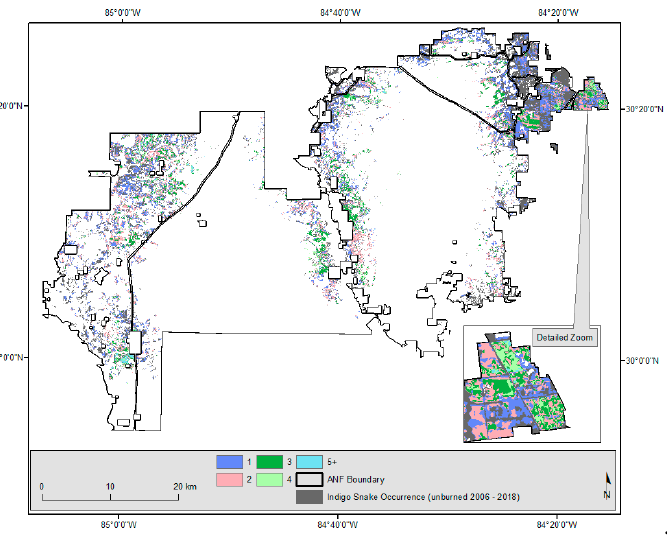
Figure 5. Fire frequency (2006–2018) restricted to Indigo snake occurrence locations is shown across the Apalachicola National Forest (ANF) at 30 m resolution. This example application demonstrates how the FRQ fire metrics can be potentially used to guide species-level habitat management activities. White indicates parts of the ANF outside of Indigo snake occurrence data.